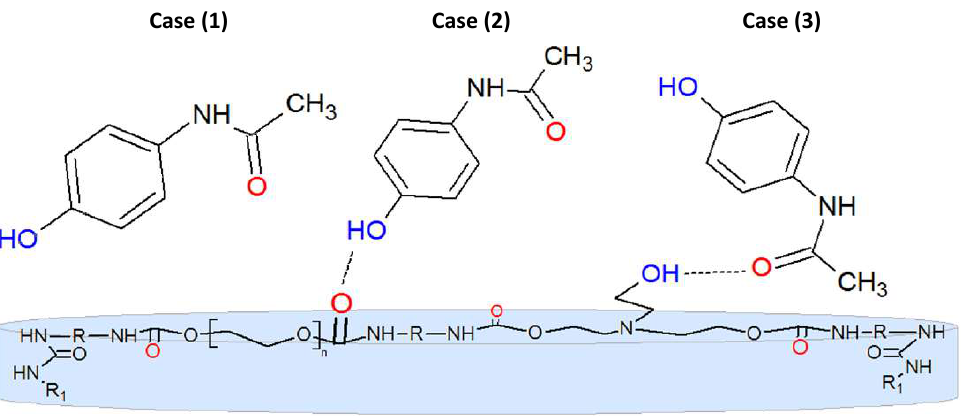
Figure 8. Three possible interactions of a PAR molecule with a hydrogel